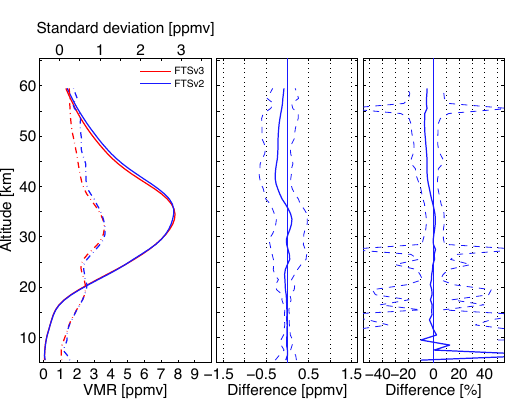
Figure 1: An example of the ACE-FTS direct version comparisons for O for the 30-60º S latitude range. This 3 compares the version 2.2 O update (blue) product with 3 the version 3.0 (red) product. The mean VMR profiles (solid lines) and the 1- σ standard deviations (dot-dashed lines) are shown in the left panel, the absolute differences are shown in the centre panel and the relative differences are shown in the right panel. The dashed lines in the centre and right panels indicate the de-biased standard deviation of the mean